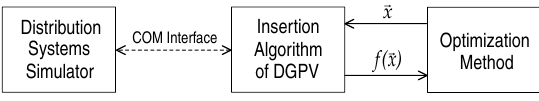
Figure 2. Proposed optimization